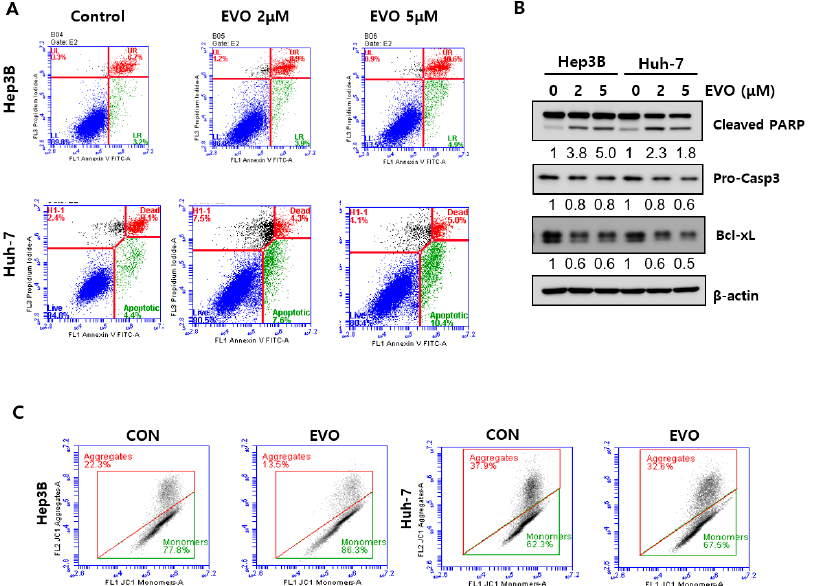
Figure 4. Apoptosis induction by evodiamine. ( A , B ) Hep3B and Huh-7 cells were treated with the indicated concentration of evodiamine for 48 h, stained with Annexin V/PI, and analyzed by flow cytometry ( A ). This was followed by immunoblotting analysis with the indicated antibodies. The loading control was β -actin ( B ). ( C ) Huh-7 and Hep3B cells were treated with the indicated concentration of evodiamine for 48 h and stained with JC-1, analyzed by flow cytometry. The numbers under the western blot indicate the relative intensity of the band. CON, control; EVO, evodiamine.